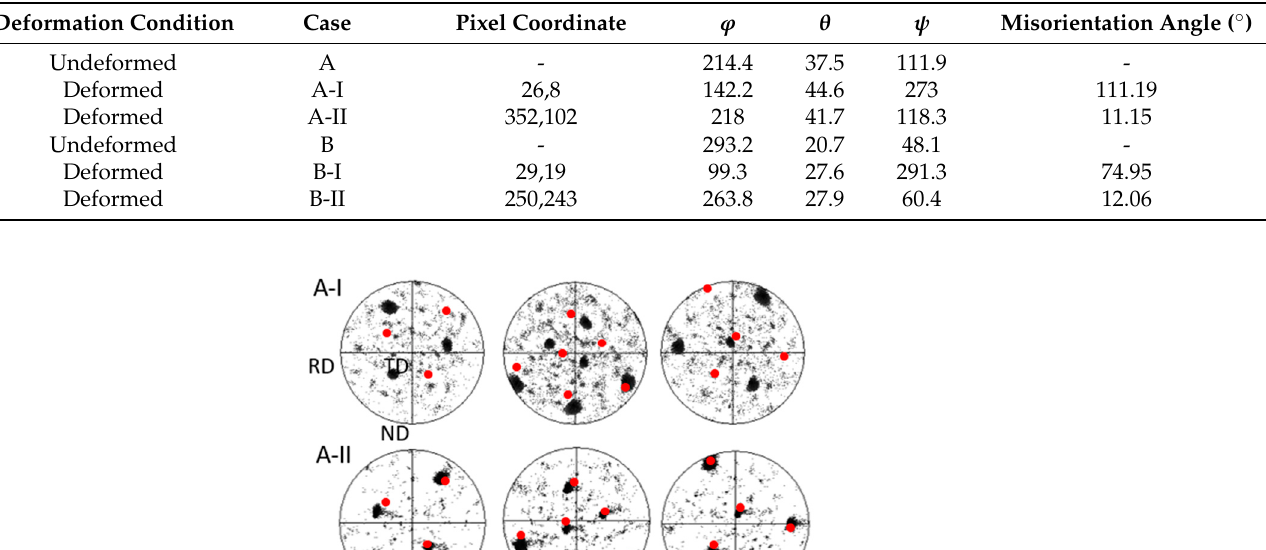
Table A1. Euler angles for the oriented crystal in the undeformed and deformed matrix.